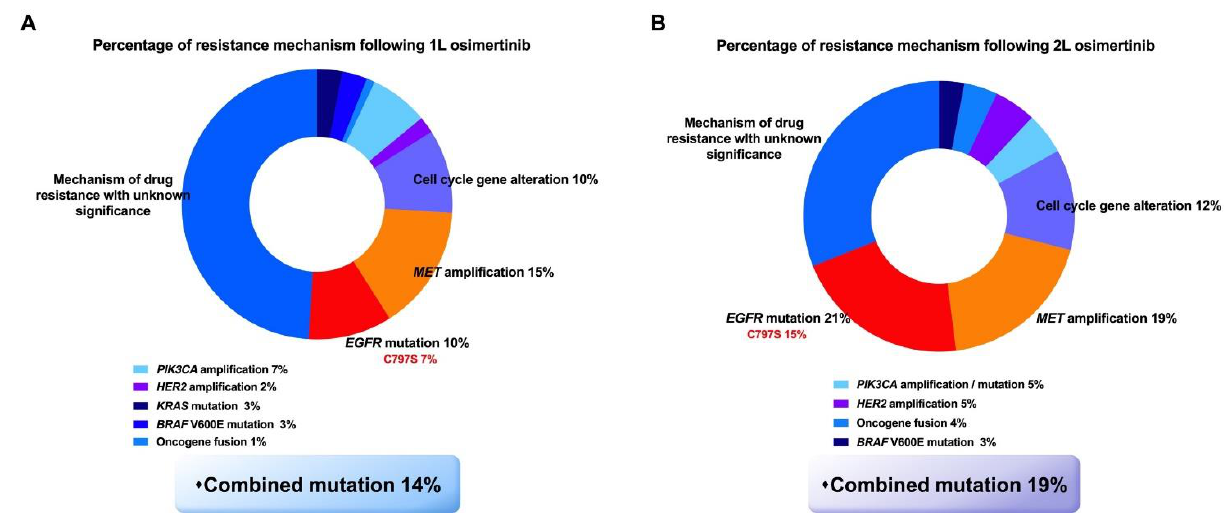
Figure 4. Difference of acquired resistance mechanisms between first-line ( A ) and second-line ( B ) treatment of third-generation TKI osimertinib. Adapted from [76,77], published by Future Medicine, 2018 and Elsevier, 2018